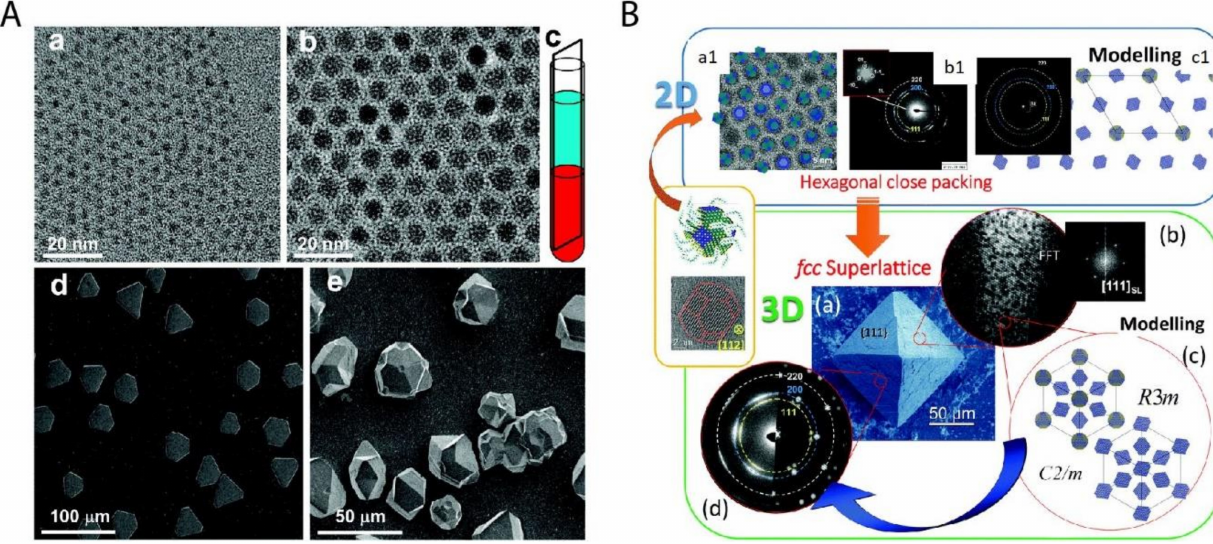
Figure 4. Two important examples of superstructures from the bottom-up organization of nanoparticles. ( A ) The colloidal superlattices made of spherical PbS nanoparticles of 3.1 nm ( a ) and 8.0 nm ( b ) are shown in ( d ) and ( e ) respectively; ( c ) shows the schematic fabrication approach of the oversaturation technique for growing superlattices. ( B ) The piece of mesocrystal, as shown in the green box: ( a ) is the SEM image of the mesocrystal with ( b ) the corresponding Fast Fourier transform (FFT) of one Focused ion beam (FIB) slice, ( c ) the simulated structural models of the mesocrystal, and ( d ) the experimental and simulated electron diffraction (ED) pattern. The mesocrystal was synthesized by the bottom-up fabrication from truncated octahedrally shaped PbS nanoparticles of 5.5 nm, as shown in upper left ( a1 ) with ( b1 ) the corresponding ED pattern of the 2D assembly and ( c1 ) the structural modeling of the assembly in the blue box. Reproduced with permission from [45], Copyright the American Chemical Society, 2010; and [47] Copyright the Royal Society of Chemistry,